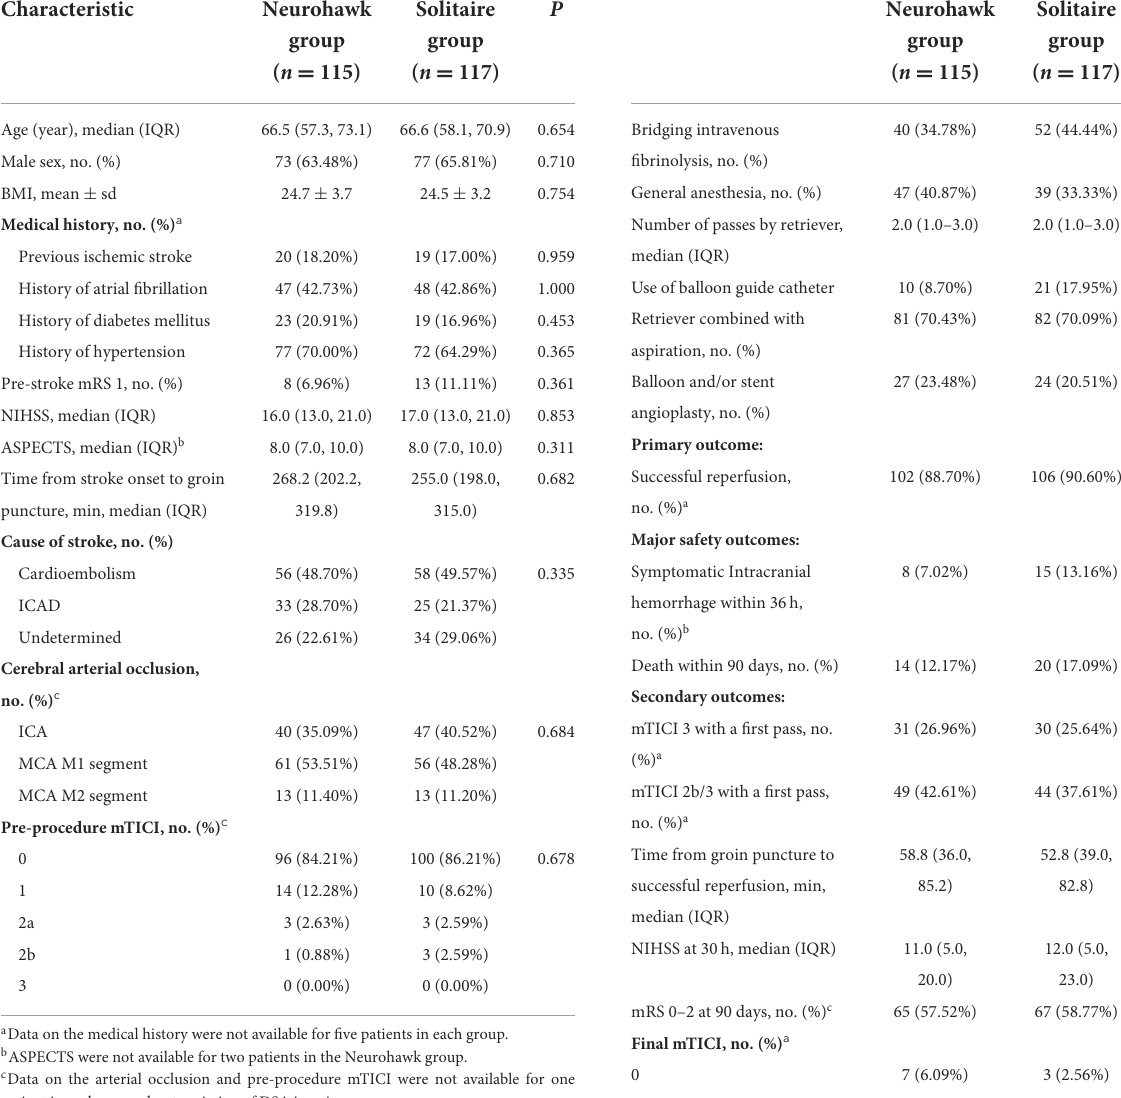
TABLE 1 Baseline characteristics of the 232 patients. TABLE 2 Procedural and outcomes